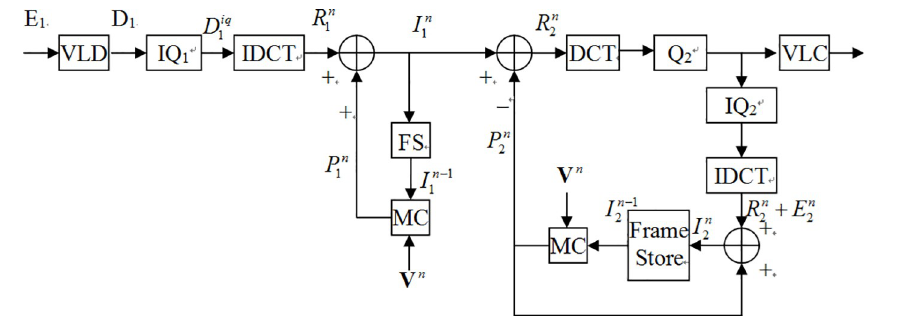
Fig 2. CPDT transcoder transcoding